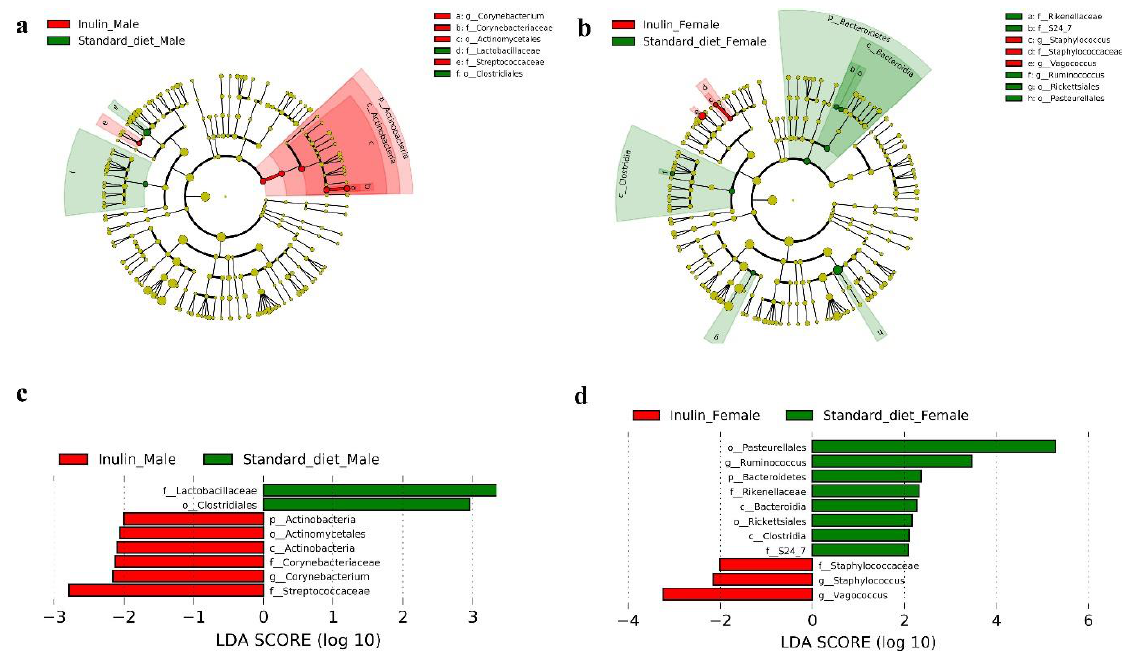
Figure 6. Nonmetric multidimensional scaling (NMDS) ( a ) principal coordinate analysis (PCoA) score plots ( b ) based on weighted UniFrac metrics and redundancy analysis (RDA) ( c ).